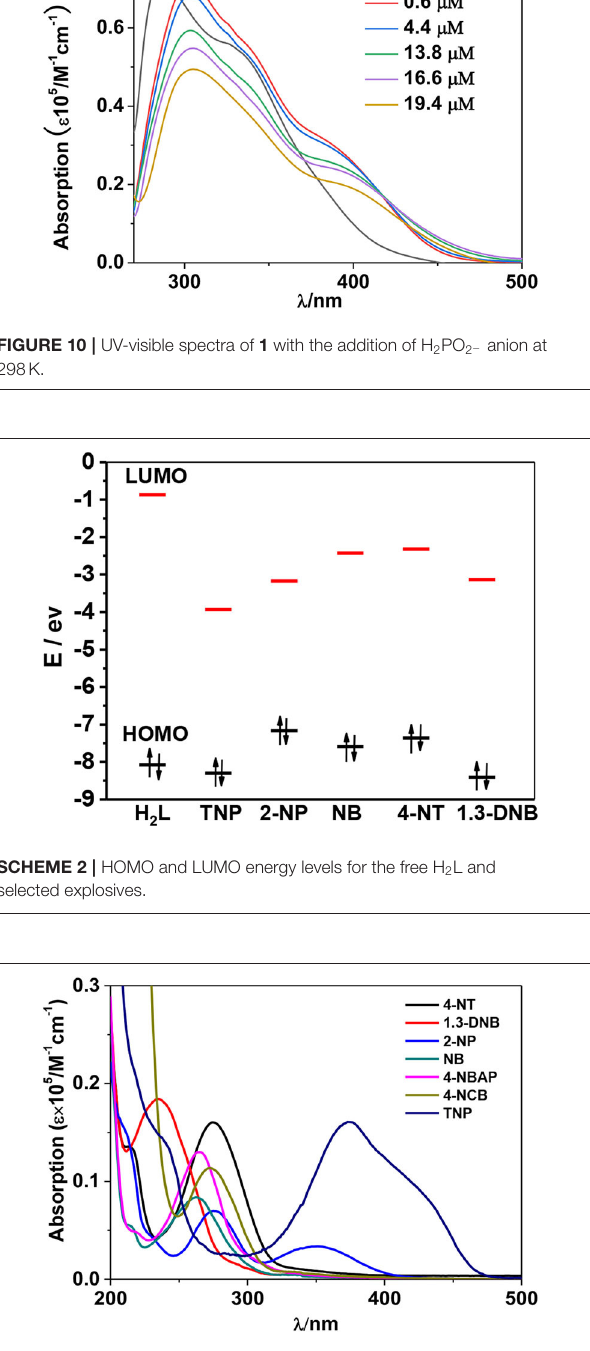
which is not advantageous for the Schiff base ligand to absorb light energy and further decreases the lanthanide luminescence (Feng et al.,